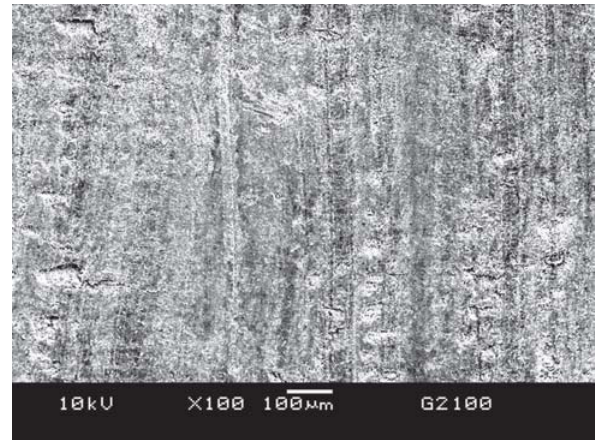
FIGURE 2- Micrograph of curette group root surface. Note the gouges that correspond to the curette tip and scratches in the stroke direction. Original magnification